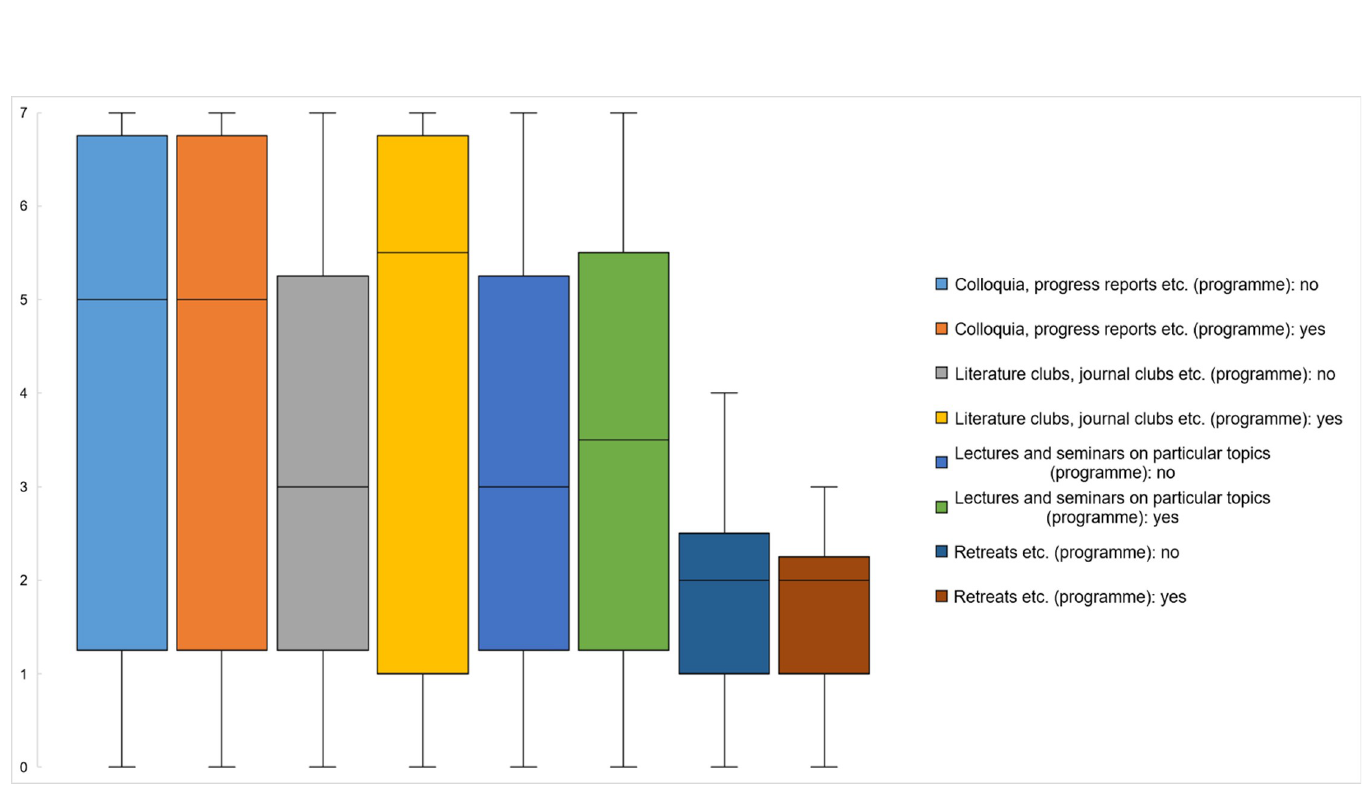
Fig 7. Frequency of visiting formal learning formats and programme regulations ( N = 229).